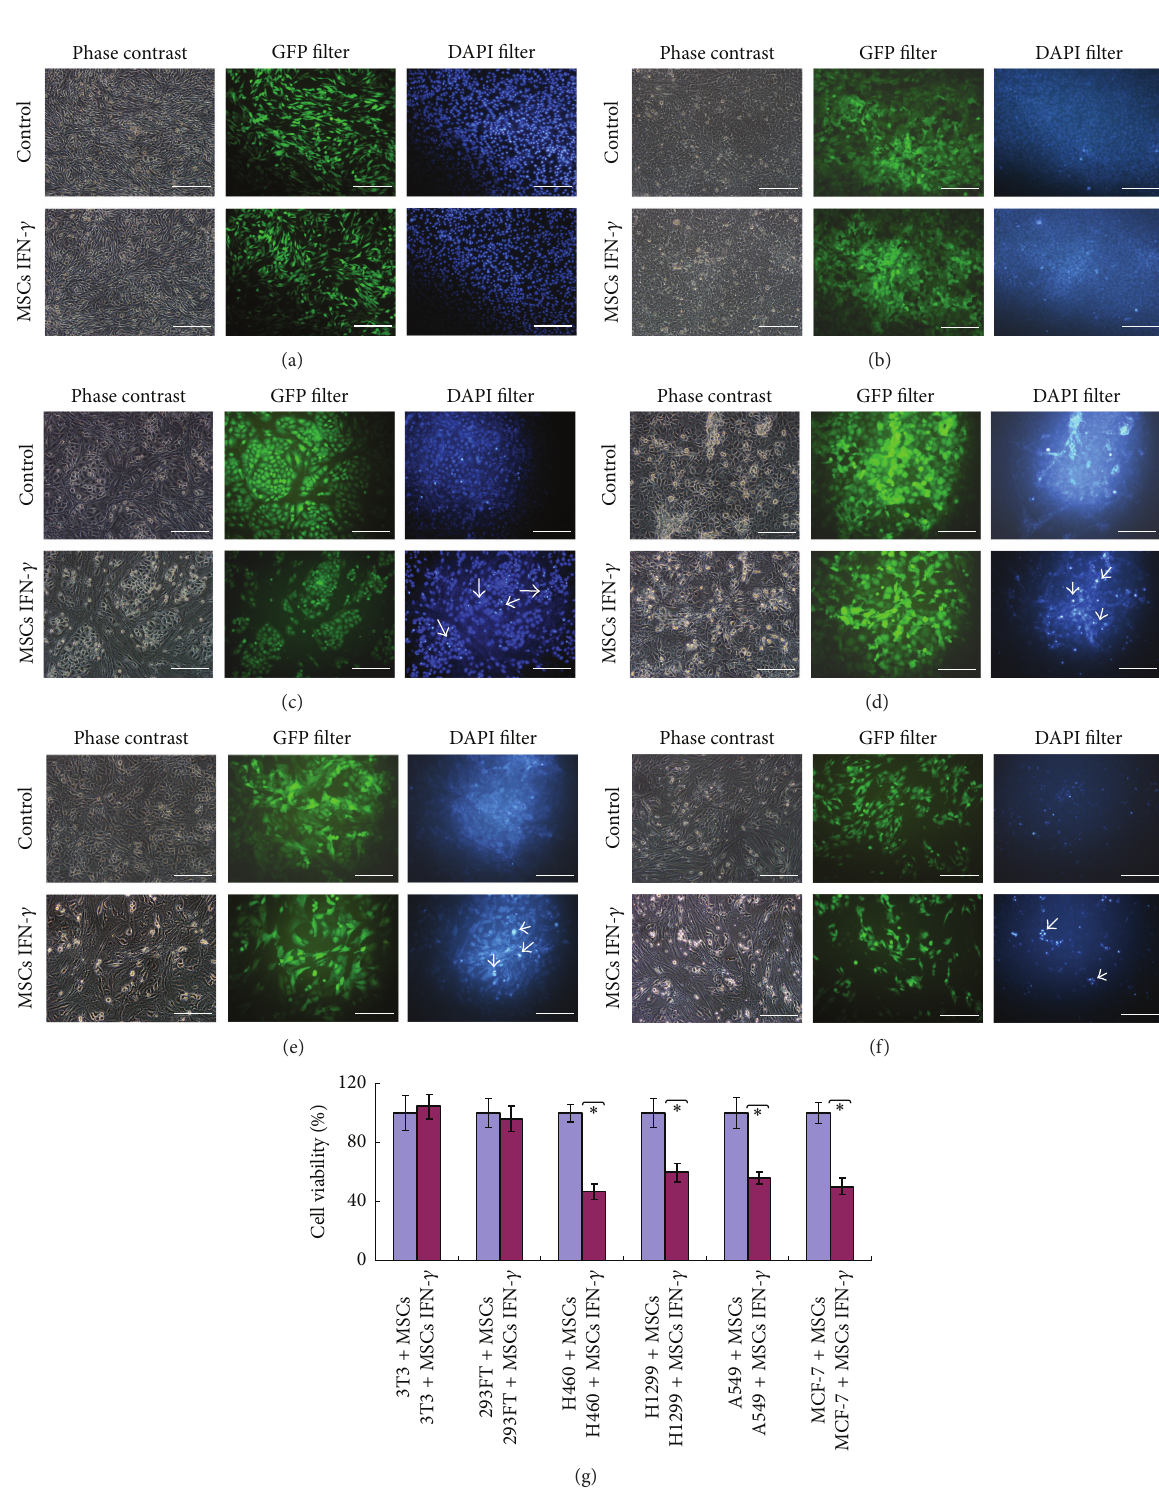
Figure 3: MSCs IFN- 𝛾 selectively induced apoptosis in cancer cells, but not in normal cells. MSCs IFN- 𝛾 were cocultured with 3T3 hrGFP (a), 293FT hrGFP (b), H460 hrGFP (c), H1299 hrGFP (d), A549 hrGFP (e), and MCF-7 hrGFP (f) cells for 48 hours. The mixed cells were observed using phase-contrast, GFP-specific, and DAPI-specific microscopy. The typical apoptotic and dead cells are marked. Scale bar: 200 𝜇 m. (g) The cell viability within the coculture system was measured using a CCK-8 kit and was shown as a percentage normalized to the viability of the control MSCs coculture group, which was set to 100%. The asterisks indicate 𝑃 < 0.01 . The reported results are representative of the results from three separate